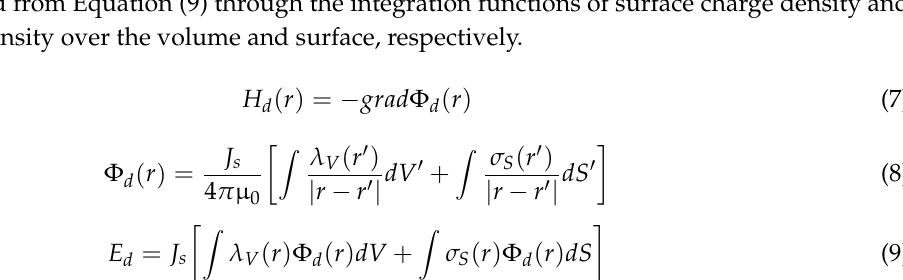
Table 1. Specifications of the two holes in the rebar.